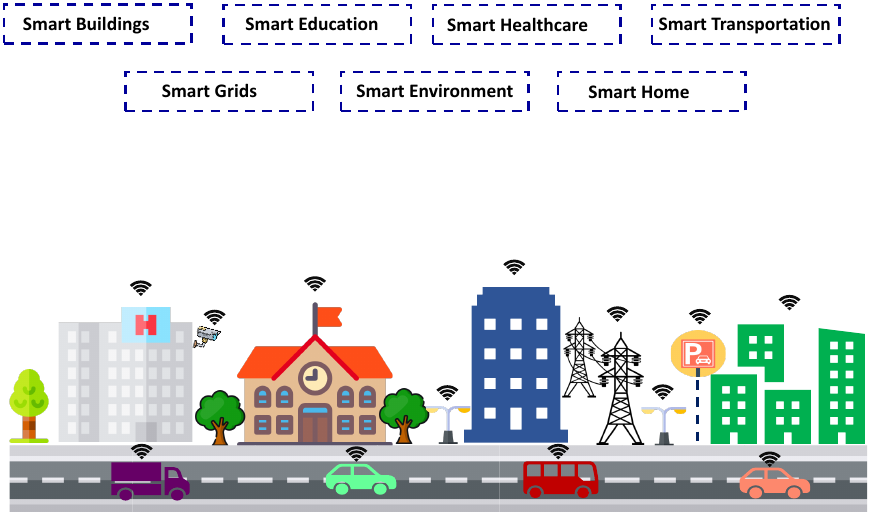
Figure 1. Typical architecture of a smart city